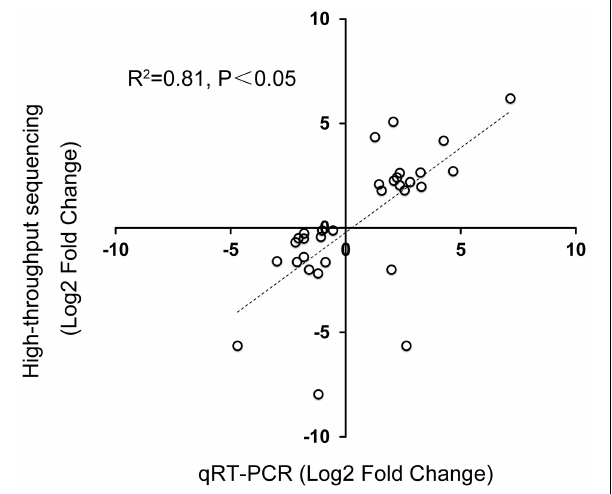
FIGURE 8 | Correlation between qPCR and Illumina sequencing data. Correlation between qRT-PCR and Illumina sequencing data of 32 selected genes: 17 upregulated genes and 15 downregulated genes in 16 pairs of amplified RNA samples. Spearman Rank Correlation coefficient = 0.81 ( P < 0 . 05